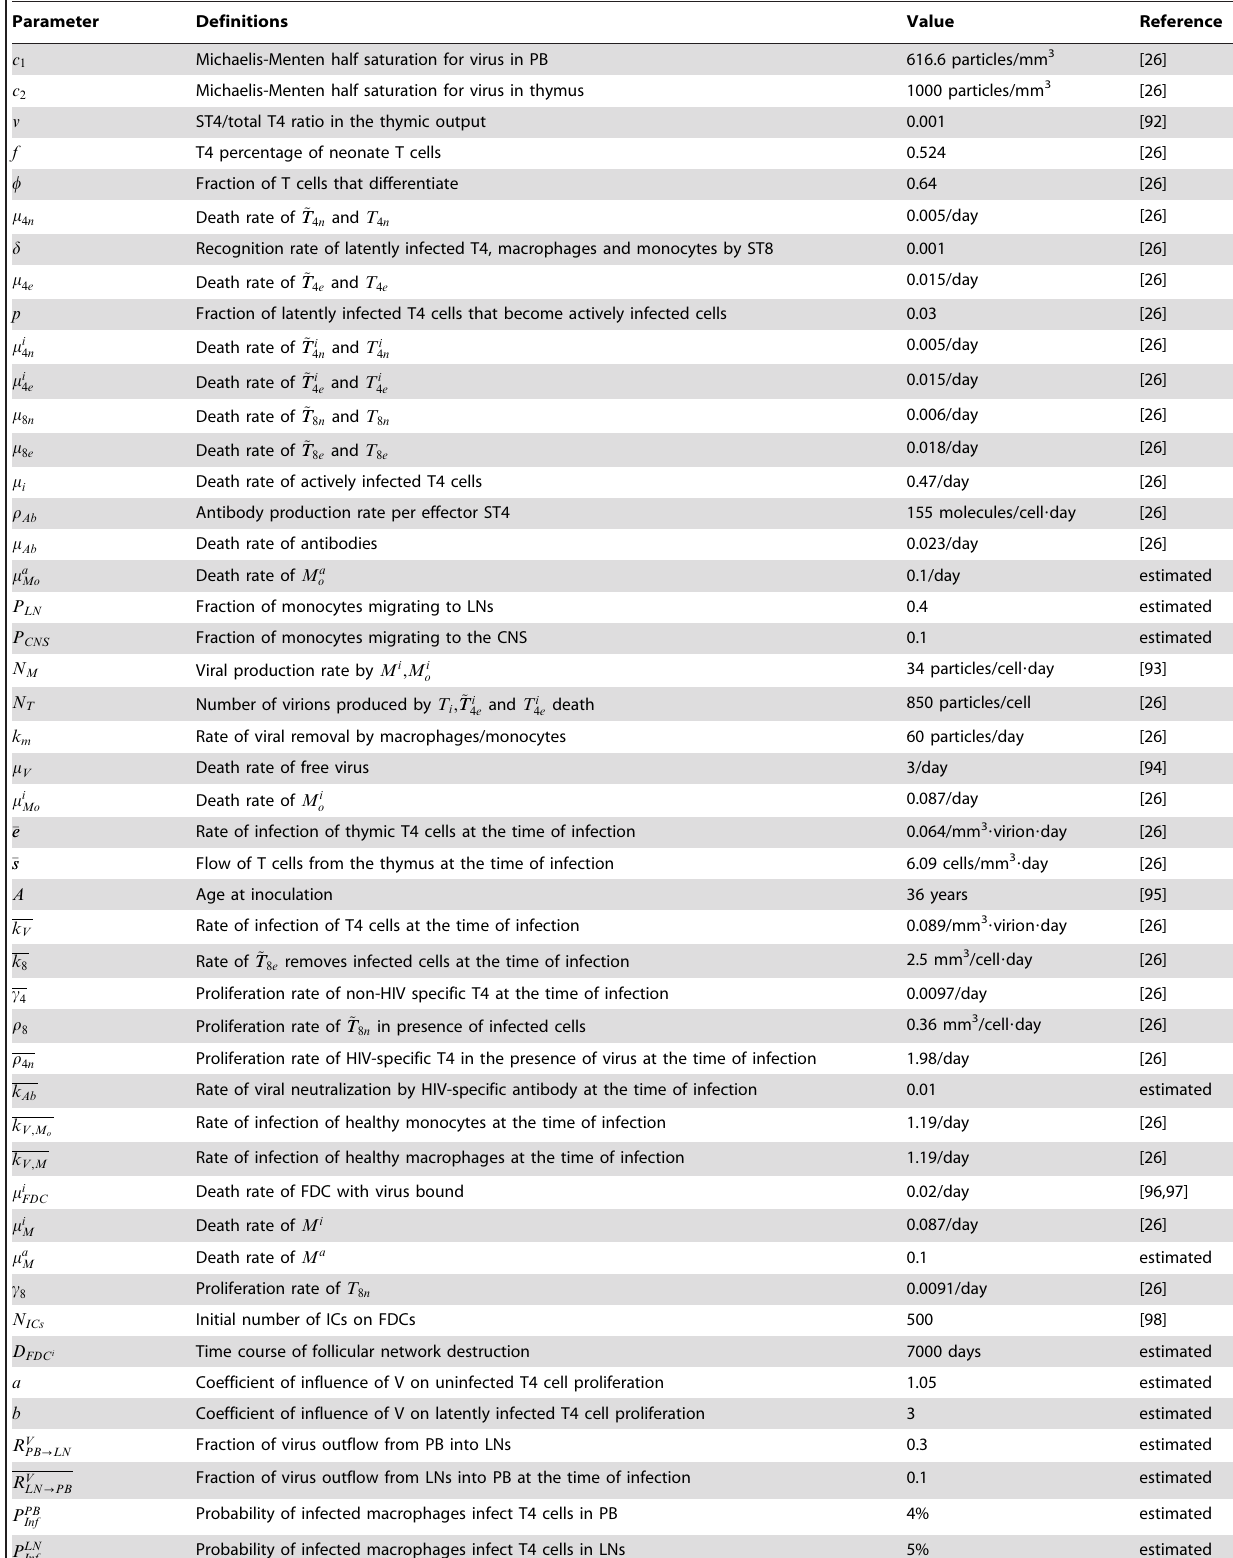
Table 7. Parameters of the model and the estimated values.